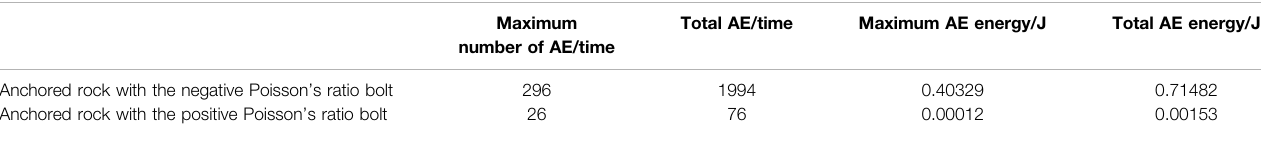
TABLE 2 | Number and energy of AE in two different anchored rocks after loading.